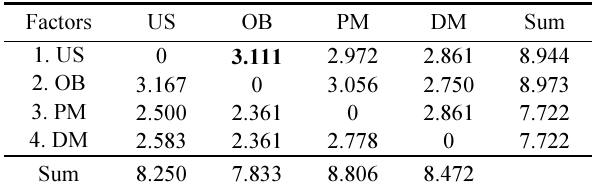
Table 7. Initial average matrix A of factors